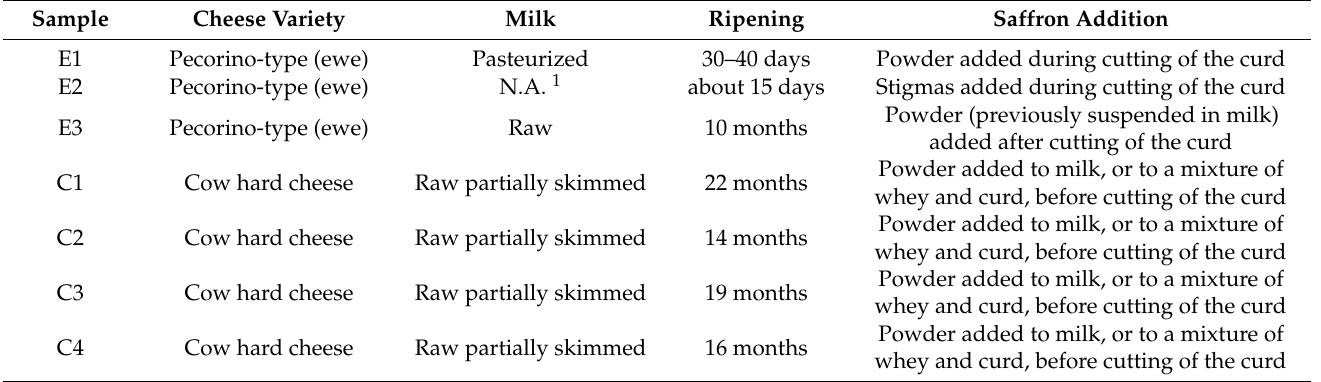
Table 4. Main characteristics of the cow and ewe cheese